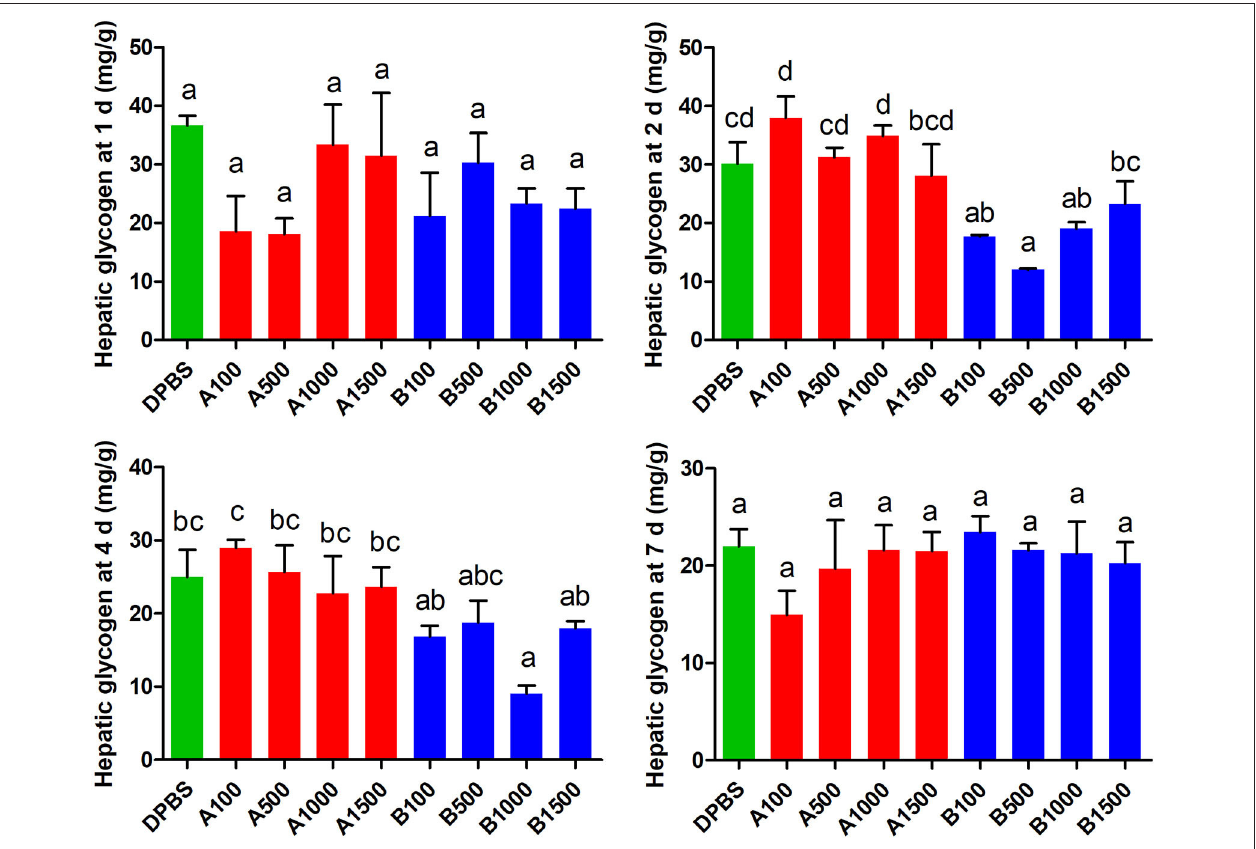
FIGURE 3 | The effects of intraperitoneal injection of LepA and LepB on hepatic glycogen levels at 1, 2, 4, and 7 d. Data represent means ± S.E.M ( n = 6). The colors of bars were shaded according to intraperitoneal injection of different solvent (green: DPBS, red: LepA, blue: Lep B). Significance level are marked with different letters ( P < 0.05), compared with the values from DPBS injected mandarin fish.